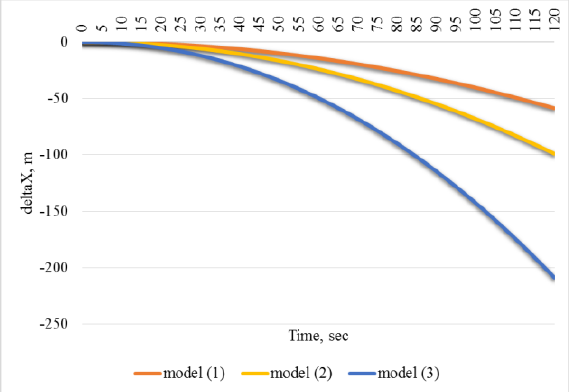
Figure 8. Total errors accumulation along X